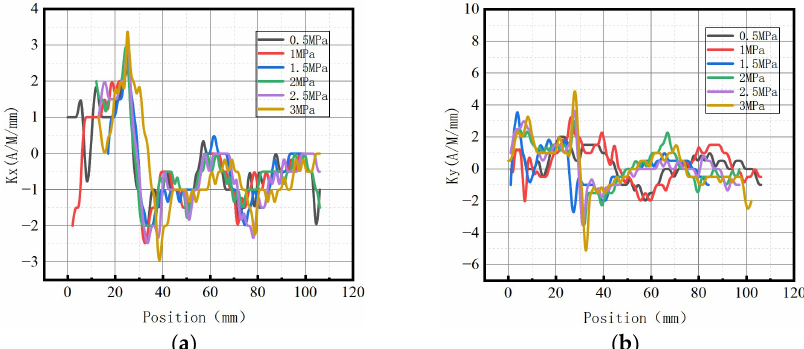
Figure 37. Variations of the magnetic field strength gradient K at the crack of base metal under different internal pressures. ( a ) The axial gradient component Kx; ( b ) the radial gradient component Ky.